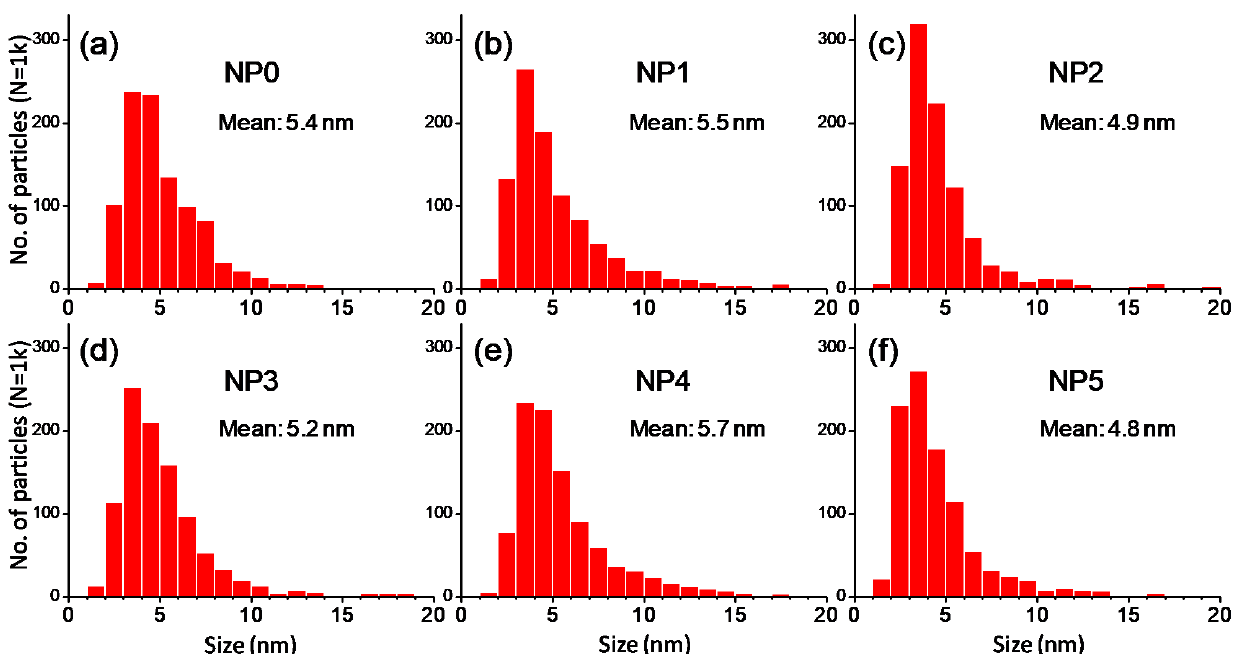
Figure 10. Histograms of particle size of the samples ( a ) NP0, ( b ) NP1, ( c ) NP2, ( d ) NP3, ( e ) NP4, ( f ) NP5. Population: 1000 particles per sample. Table 3. Statistical data of particle size: population of measured particles (N), mean size (nm), standard deviation (SD), standard error (SE), minimum size (Min), maximum size (Max), and range. Sample